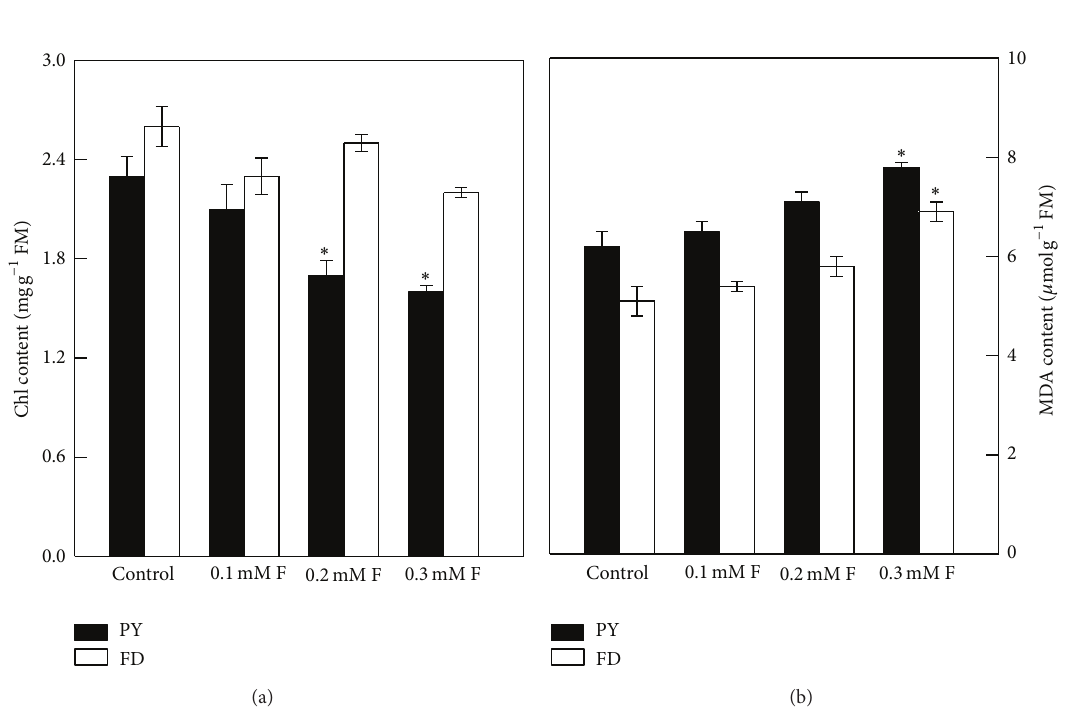
∗ Indicates a significant difference compared with the control at 𝑃 < 0.05 according to Fisher’s 𝐹 test.